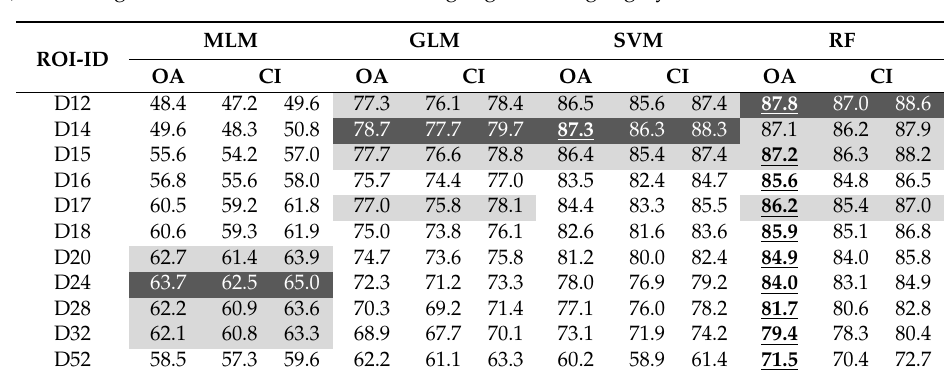
Table 3. Classification accuracy (%) by classifier type and region of interest (ROI) size. The highest overall accuracy (OA) for each diameter is in bold and underlined. White text on a dark gray box identifies the highest OA within a given classifier. ROI-IDs that overlap the 95% confidence intervals (CI) for the highest OA for each classifier are highlighted in light